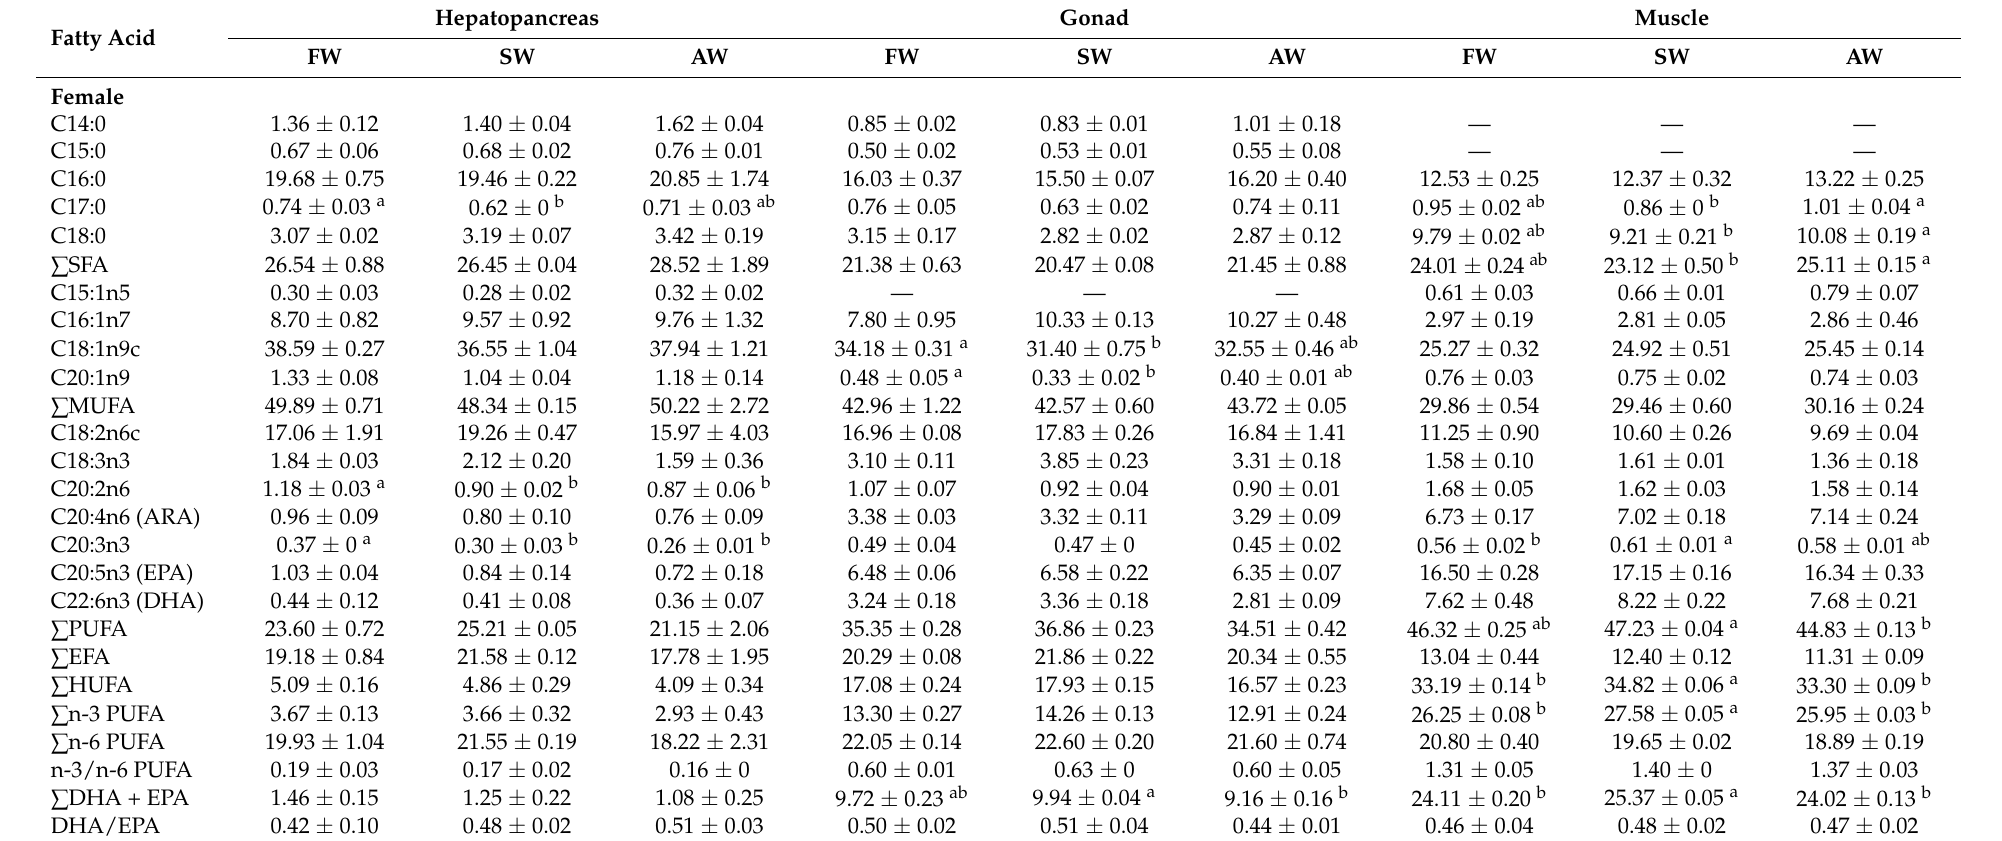
Table 2. The fatty acid composition in hepatopancreas, gonad, and muscle of adult Eriocheir sinensis fattening in different culture environments (% of total fatty